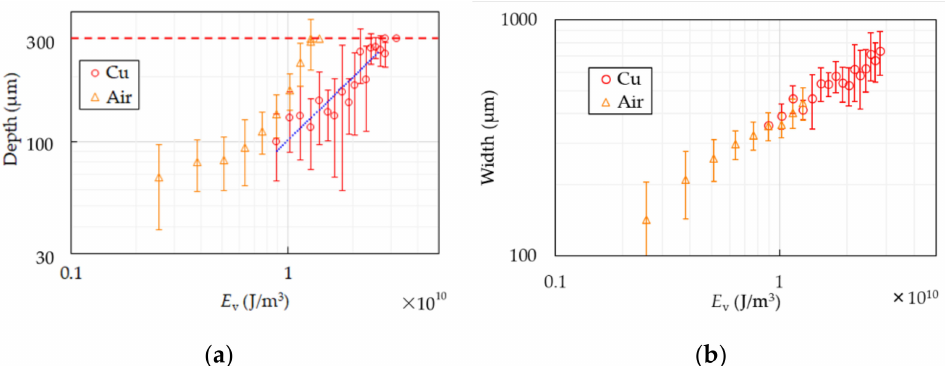
Figure 8. Depth ( a ) and width ( b ) of PS are shown. The circles show the results of the Cu cooling base and the triangles show that of air. The dash line in ( a ) represents the sample thickness. Two circles and triangles at the same E v in ( a ) mean partially penetration. Single circle and triangle with no error bar means complete cutting. The blue dot-line in ( a ) represents linear